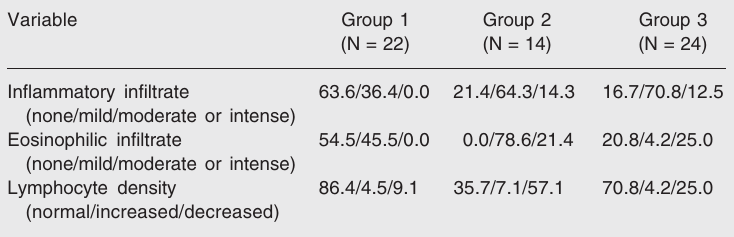
Data are reported as percentages. For group definitions, see legend to Table 1. Inflammatory infiltrate: χ 2 : P = 0.008. Wald - mild: group 1 vs group 2: P = 0.08; group